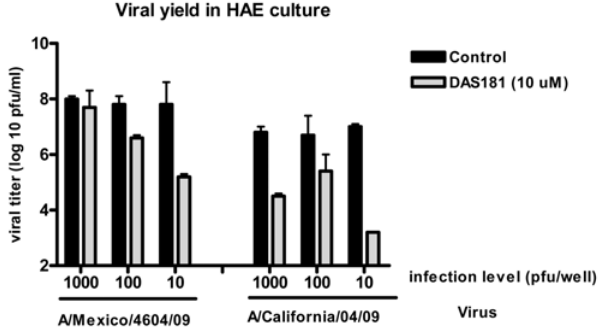
Figure 2. DAS181 inhibits pandemic IFV A(H1N1): viral yield in 2009 A(H1N1) infected HAE culture. Well differentiated primary human airway epithelium cultures (HAE) were pretreated with DAS181 for 2 hours (at 10 m M) before infection with either A/Mexico/4604/2009 or A/California/04/2009 at indicated infection levels. After 24 hrs the apical wash was collected and viral yield was determined on MDCK cells as described in Materials and Methods. Values represent mean 6 SD of quadruplicate analysis of each sample.